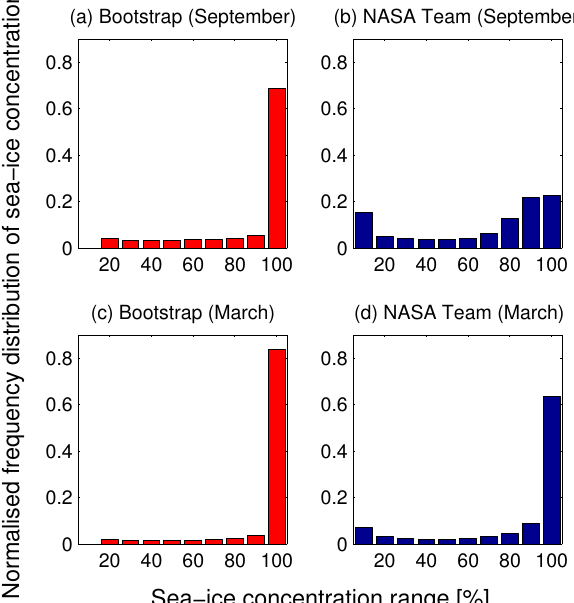
Fig. 3. Histogram of 1979–2005 sea-ice concentration in all ar- eas with at least 0.1% sea-ice concentration. (a, c) Satellite re- trievals based on the Bootstrap algorithm and (b, d) satellite re- trievals based on the NASA Team algorithm for (a, b) September and (c, d) March. The numbers on the x axis denote the upper limit of each bar: e.g. 20 denotes the concentration range 10 to